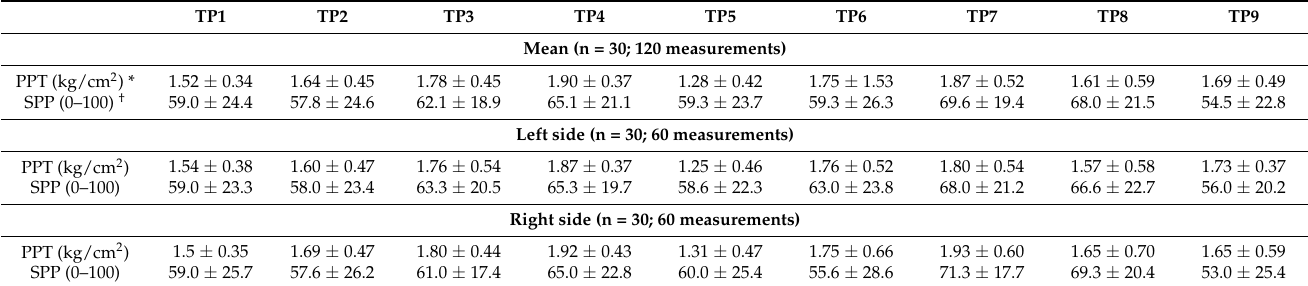
Table 2. Physical examination of Tender Points: Pain Pressure Thresholds and Subjective Pain Perception.